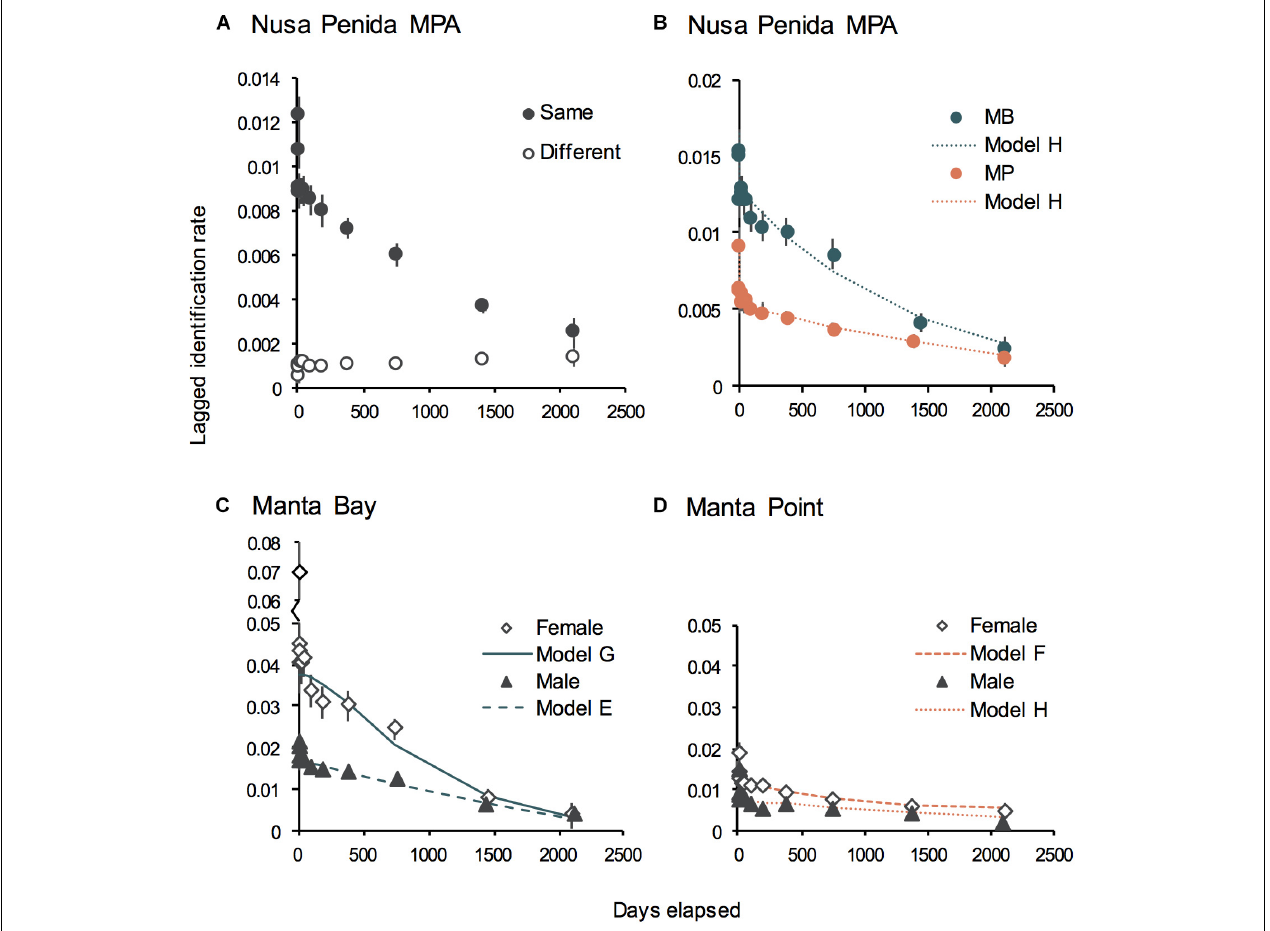
FIGURE 5 | Lagged Identification Rates (LIR ± SE) of manta rays within the two study areas, Manta Bay (MB) and Manta Point (MP), Nusa Penida MPA, Indonesia. The mean probability of re-identifying an individual manta ray, from the time of first identification until approximately 6 years later within the same or different area in the Nusa Penida MPA (A) , MB and MP (B) ; and broken down by sex within the sites MB (C) ; and MP (D) . The predicted LIRs for models of best fit ( Table 1 ) are shown for each group. Records from January 2012 to April